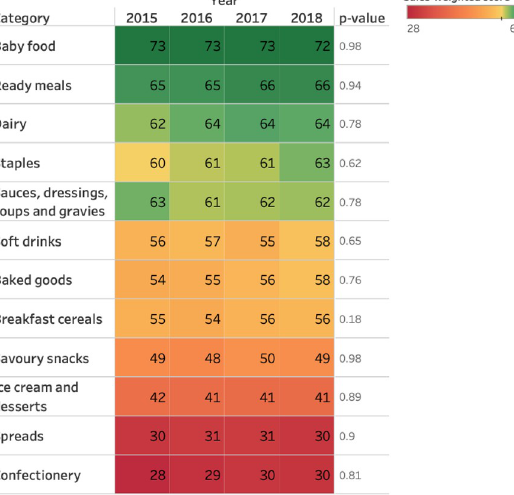
Fig 2. Total sales-weighted nutrient profiling score by category and